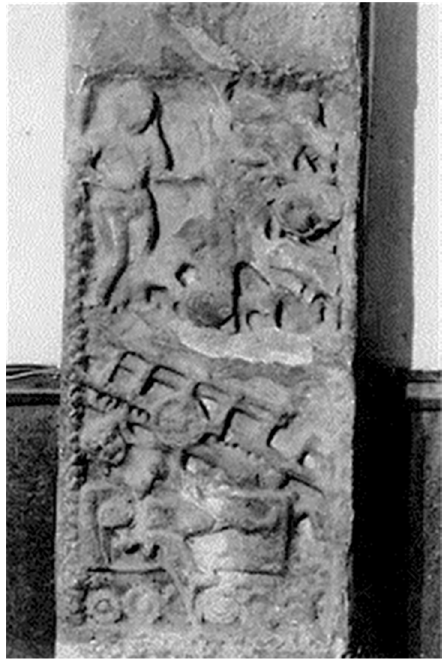
Figure 4. Detail of Figure 2: Churning of the Butter.